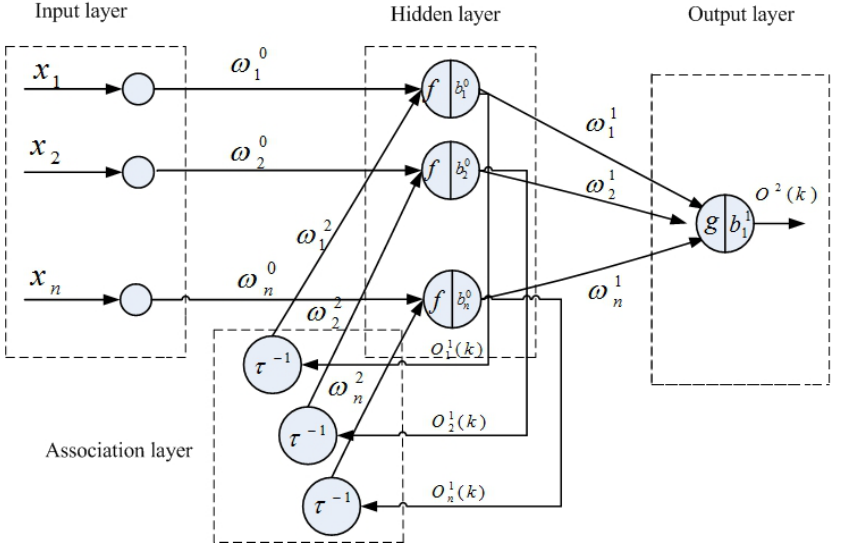
Figure 4. Structure of an Elman neural